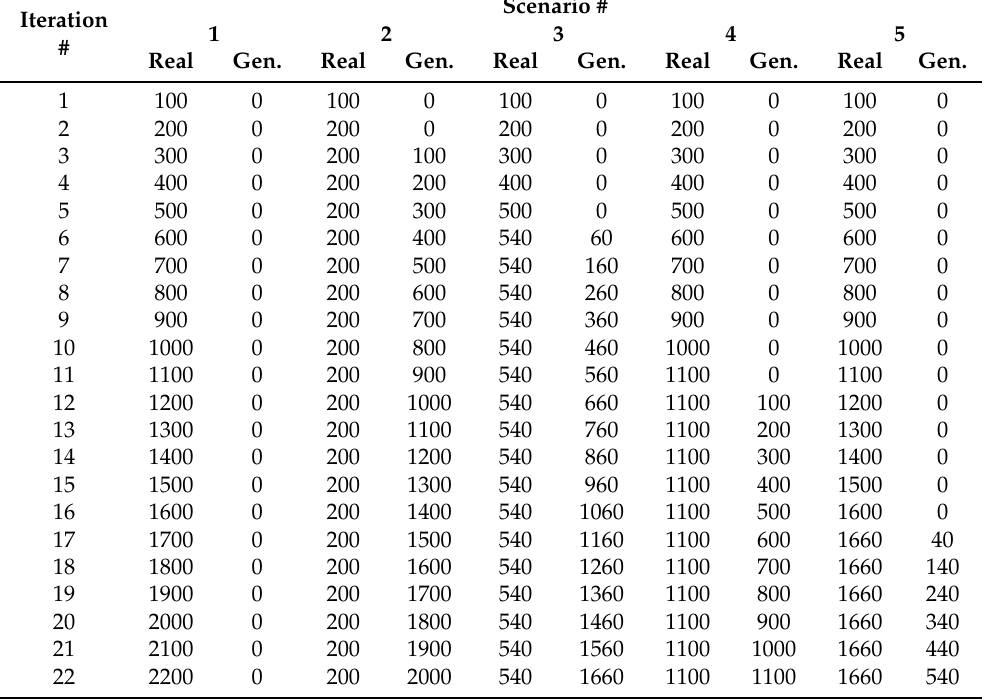
Table 3. Composition of training dataset for each iteration given a particular training